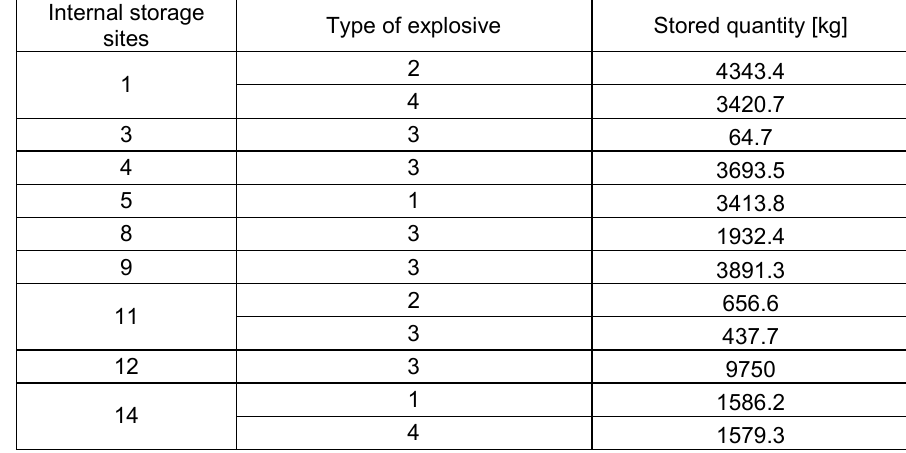
Table 5 – Solution of the QDACLP numerical example Таблица 5 – Решение численного примера